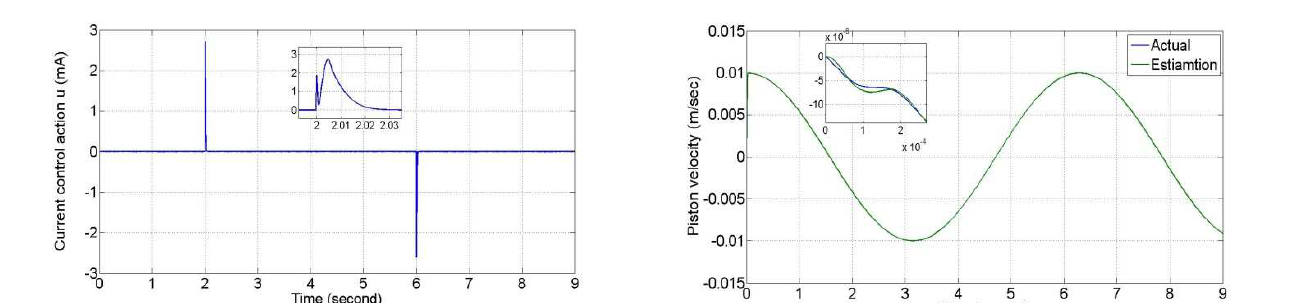
Fig. 17. Closed loop piston velocity parametric uncertainties with desired (cid:159) = (cid:160). £ sinusoidal position. (cid:159) = (cid:160). £